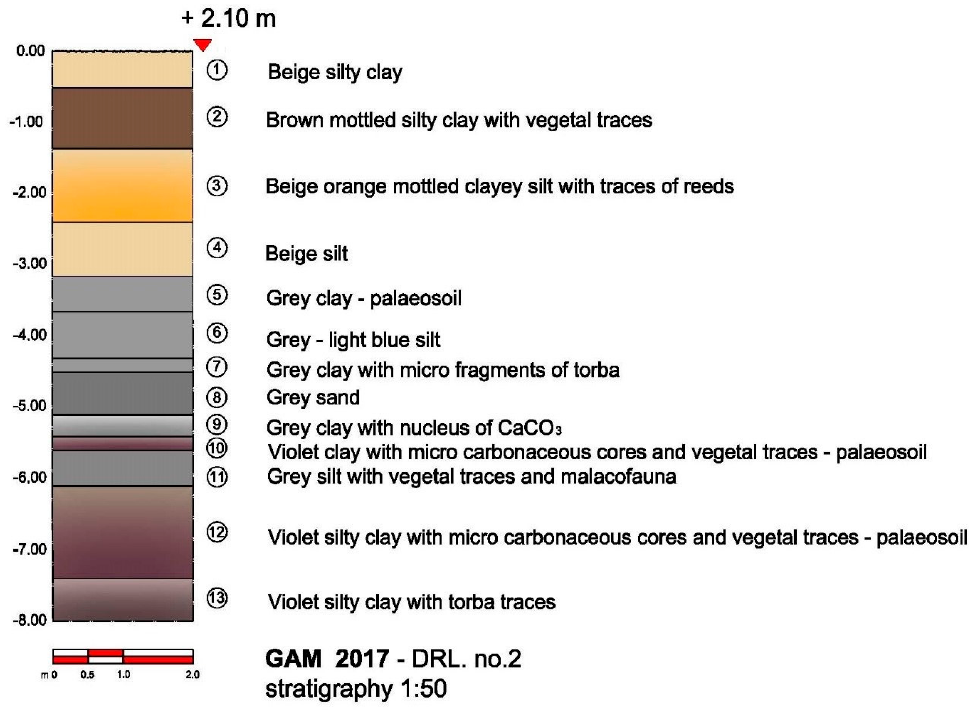
Figure A2. Graphic depiction of drilling No. 2 in 2017 in Lago Tramonto, Gambulaga, Portomaggiore (FE, Italy).